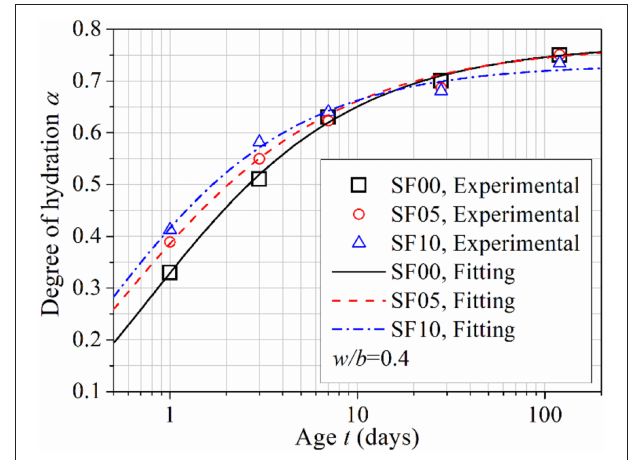
FIGURE 7 | Evolutions of α and α SF in cement-SF blended pastes.